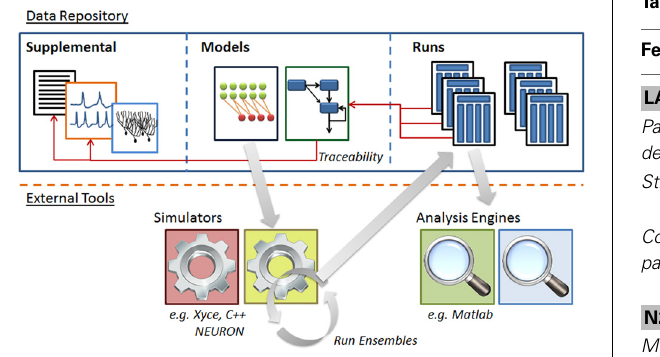
FIGURE 5 | Structure of N2A software database. N2A stores three types of information within the database. (1) Raw data such as references and parameter fits that helps define parts’ behavior (left), (2) model descriptions which consist of a set of parts and connections and information concerning their initialization and inputs (center), and (3) ensembles of runs that include model configuration, runtime metadata and results (right). N2A uses external simulation tools and analytical environments, though it does include a reference simulator implemented in C ++ (bottom).